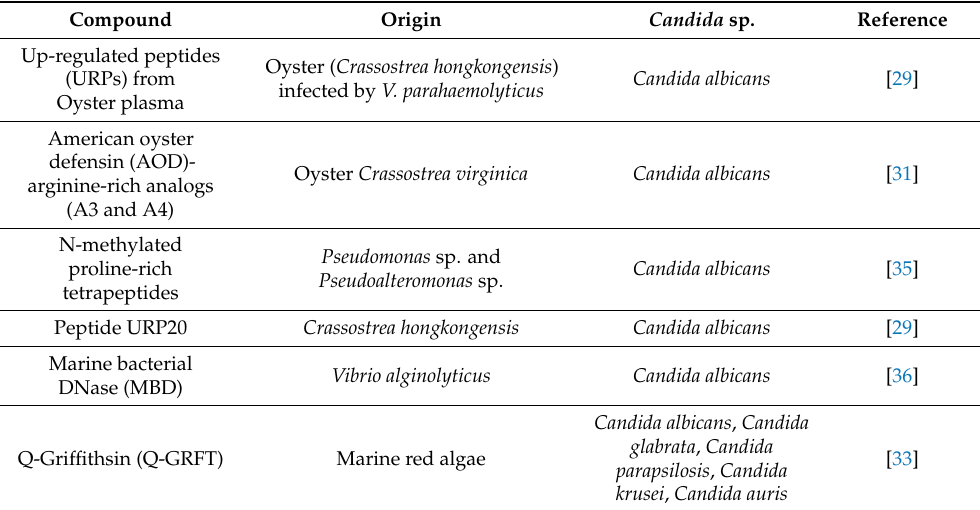
Table 1. Antifungal activity of marine peptides and proteins. Compound